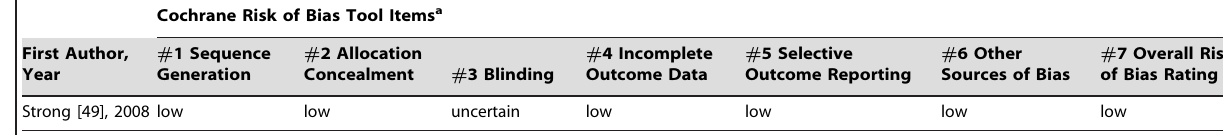
Cochrane Risk of Bias Tool Items